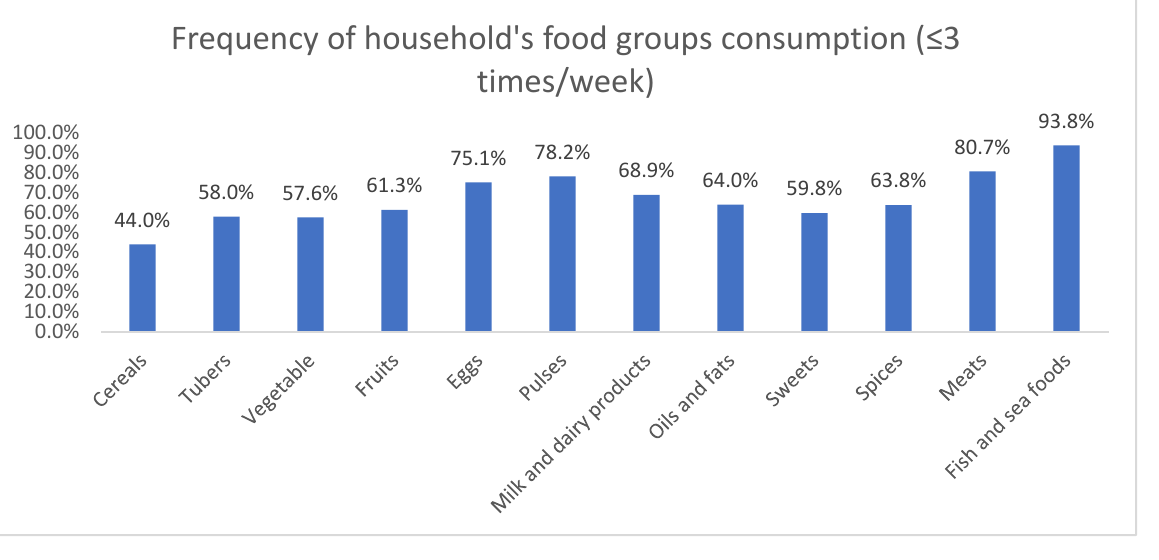
Figure 1. Frequency of foods group consumption ( ≤ 3 times/week) among participants’ households.